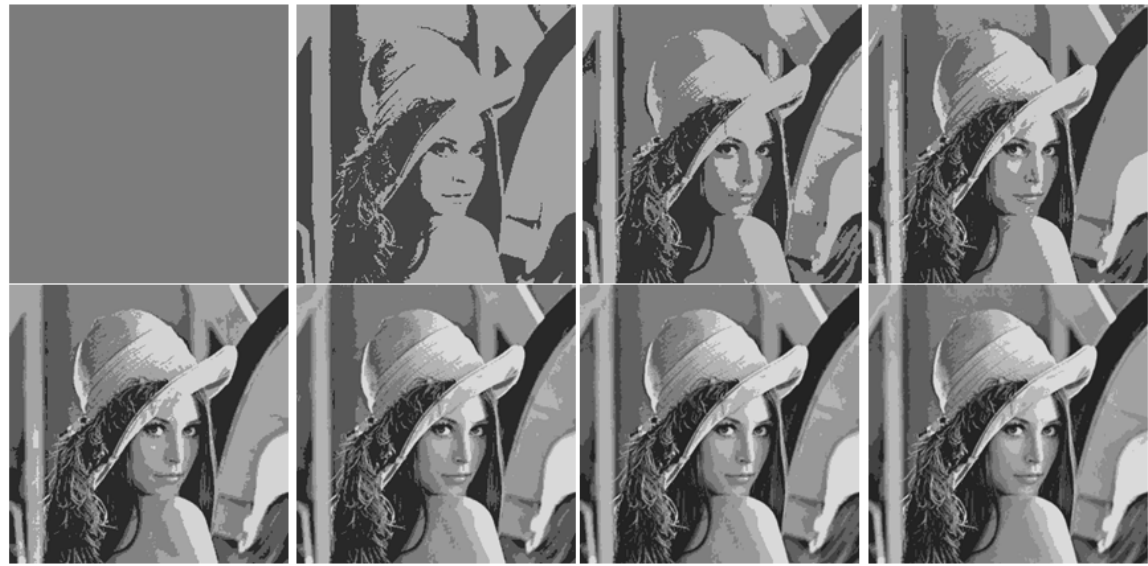
Figure 4. Optimal approximations of a standard image in 1–8 tones, ordered from left to right and top to bottom.